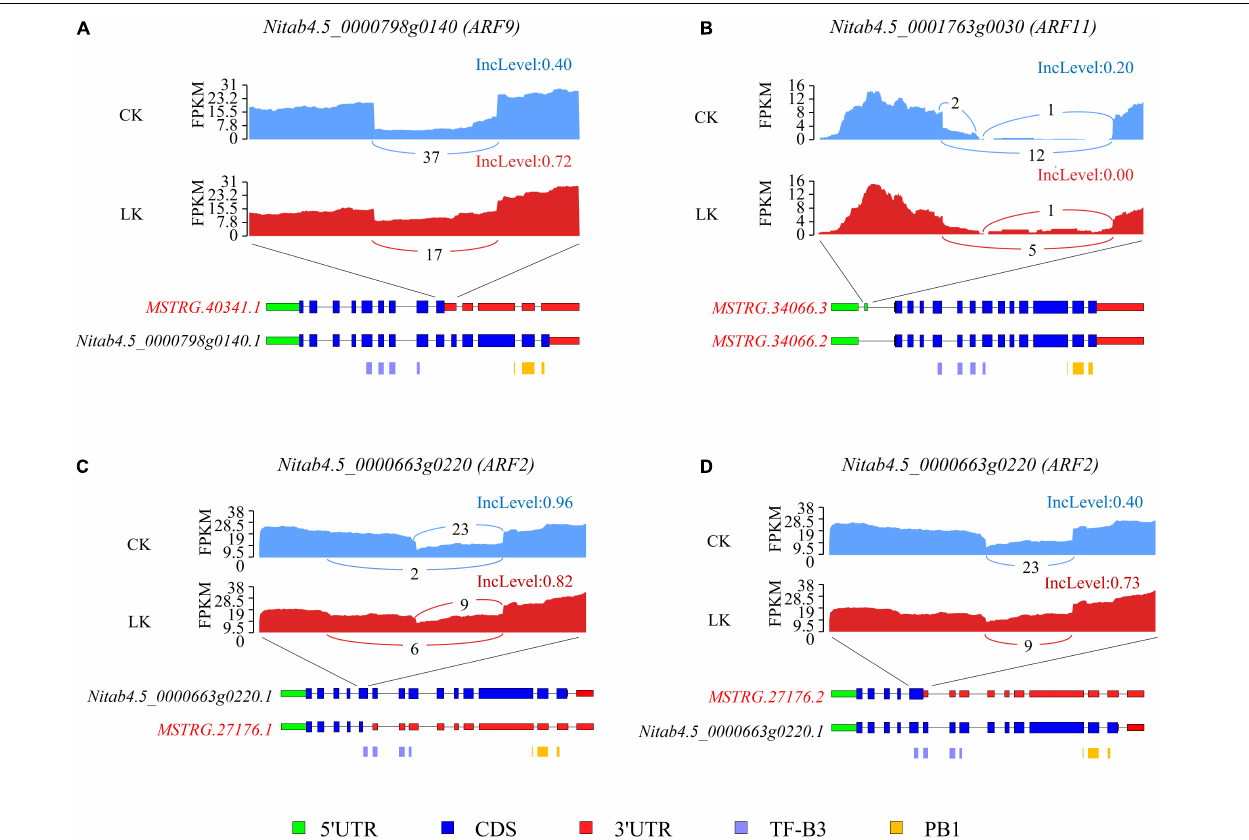
FIGURE 8 | Alternative splicing (AS) of three ARF genes under K + deficiency conditions in tobacco root. Visualization of the exon-intron structure of representative transcripts for ARF9 (A) , ARF11 (B) , and ARF2 (C,D) genes in root under K + deficiency conditions. Sashimi plots show the number of RNA-seq reads mapping to loci associated with AS events. The heights of the bars represent FPKM. Structure diagrams below the sashimi plots show the 5 (cid:48) UTRs (green), coding exons (blue), 3 (cid:48) UTRs (red), and specific protein domains (purple, orange) in major transcript isoforms. Upper numbers in the sashimi plots indicate the inclusion counts (IJC), and lower numbers indicate the skipping counts (SJC) described in Figure 3A . CK: control condition; LK: low K + stress; IncLevel: inclusion